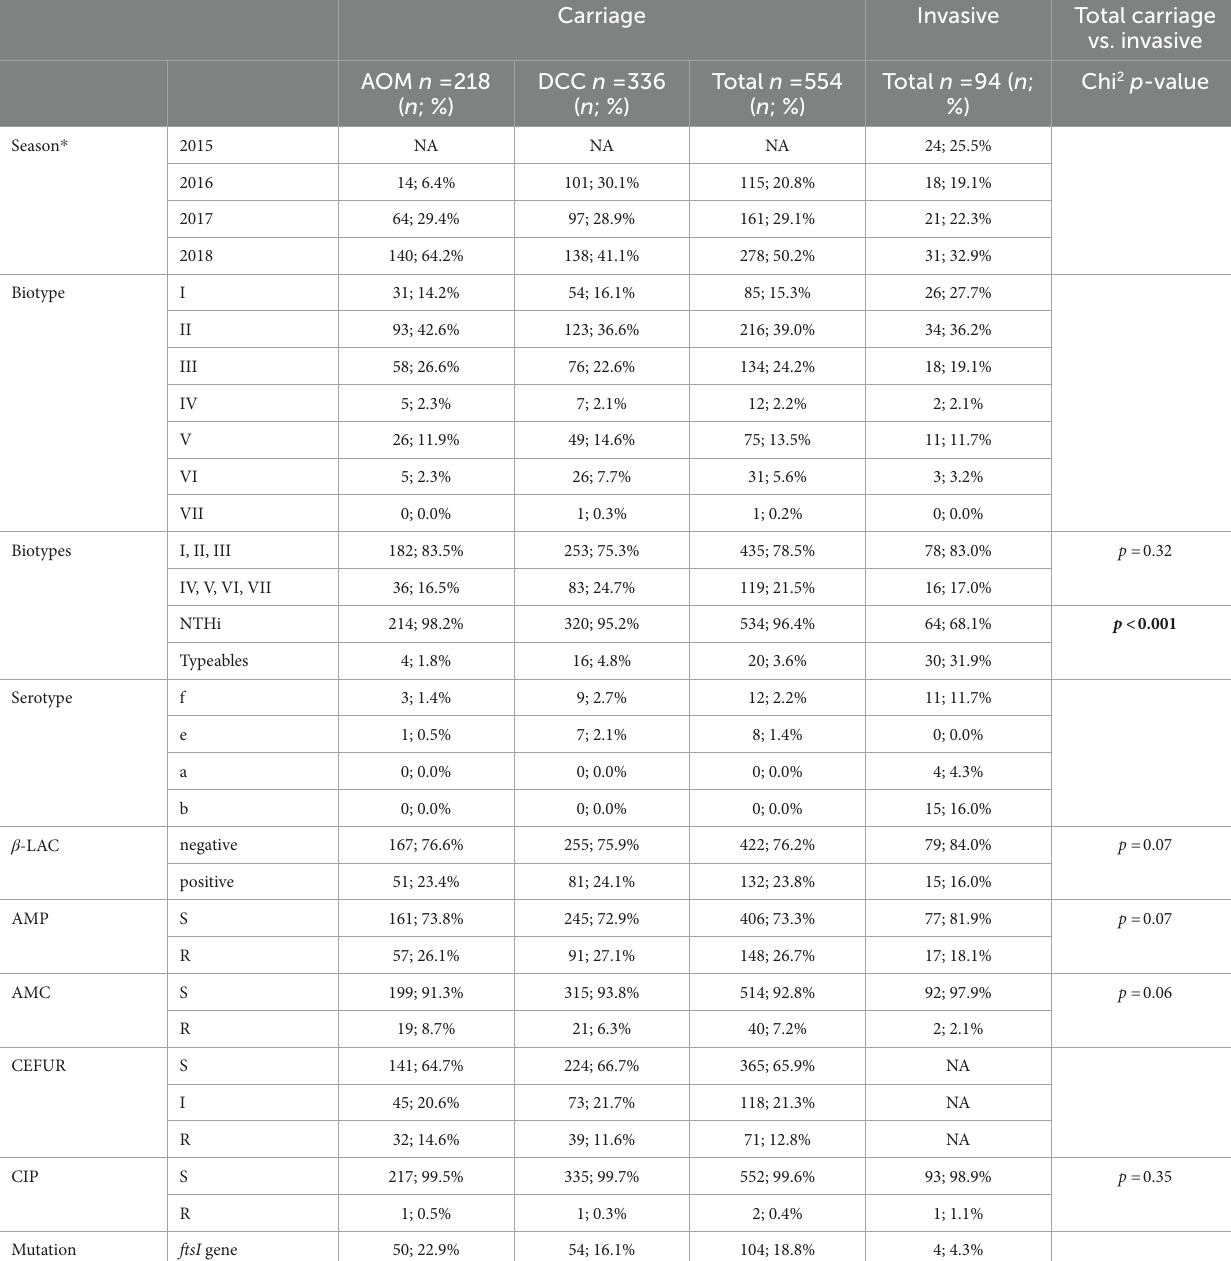
TABLE 1 Characteristics of Haemophilus influenzae strains in the carriage (AOM and DCC) and invasive group.